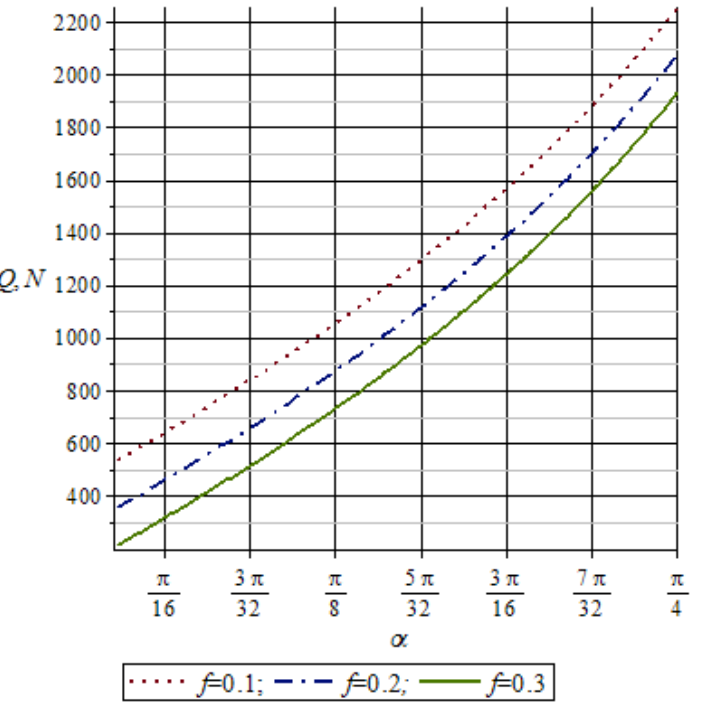
Figure 6. Graph of changes in the pressure force of the working rolls depending on the difference in the nip angle.